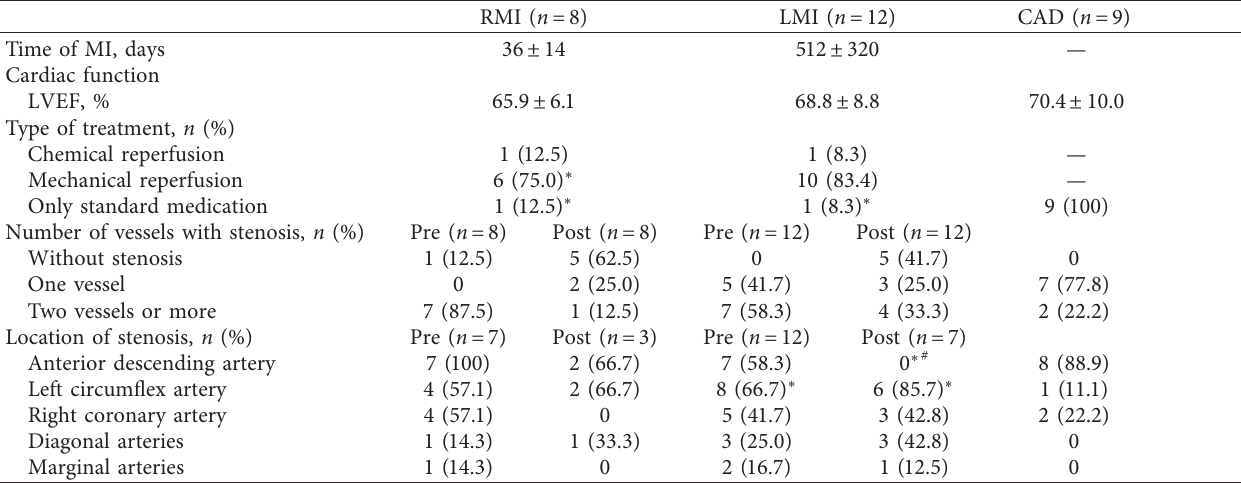
Table 2: Clinical data of groups with coronary artery